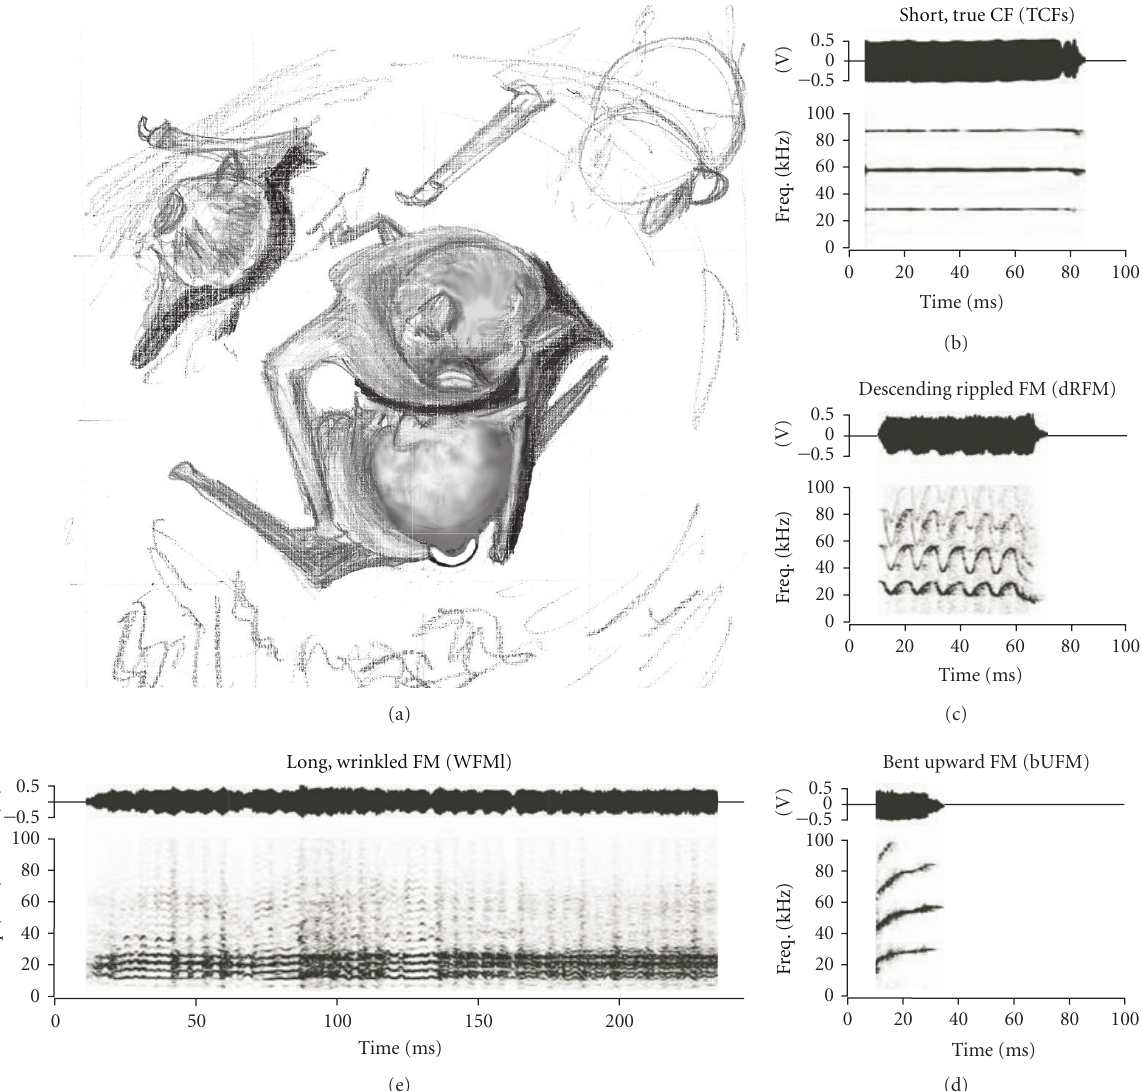
Figure 5: (a) Fighting among two males. (b), (c), and (d) Amplitude envelopes (above) and spectrograms (below) of associated simple syllabic calls. (e) A relatively long sequence of a composite consisting of long, wrinkled FM, broadband noise and sinusoidal FM type of simple syllabic elements. Abbreviations: Freq. = frequency; V =